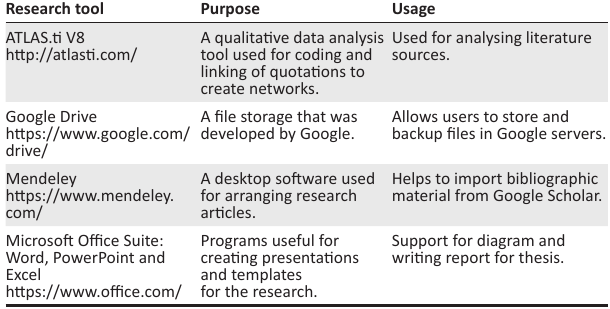
TABLE 2: Research tools used for data collection adapted from Harpur (2018). Research tool